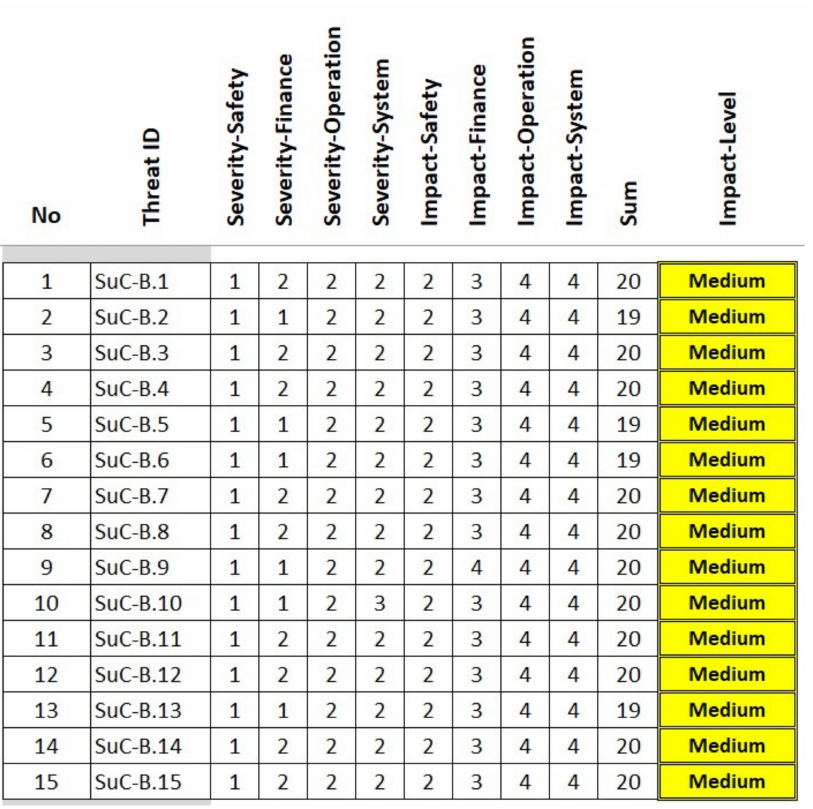
Figure 7. Cybersecurity impact analysis